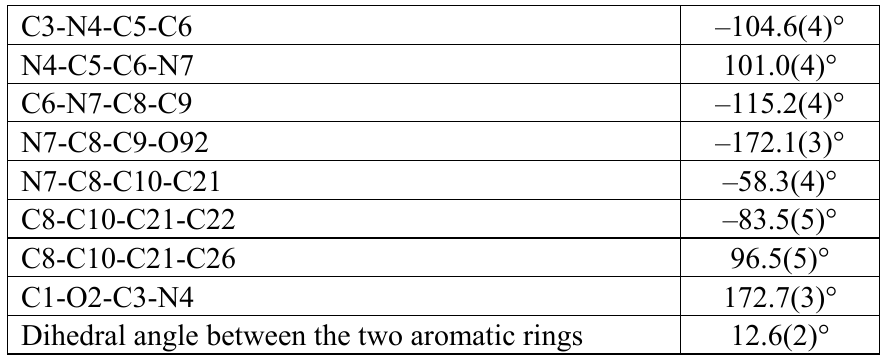
Table 1. Selected torsion angles for (Z-AF-OMe) [ ° ].